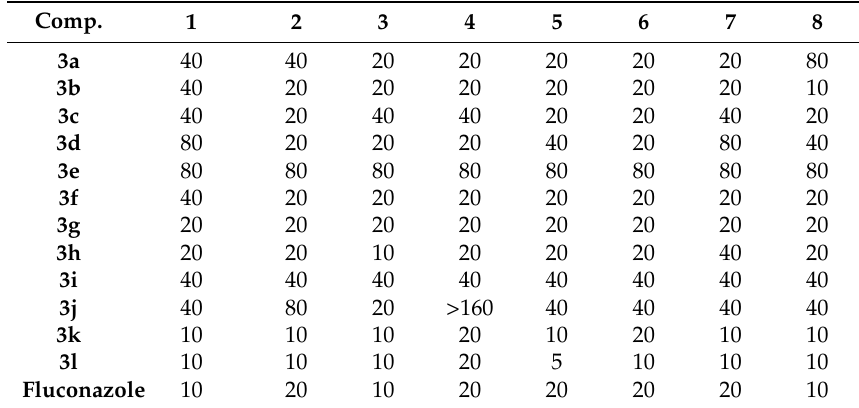
Table 1. Minimum inhibitory concentration (MIC 50 ; µ g/mL) values of compounds on eight strains of Candida ( 3a – 3l ). Comp.